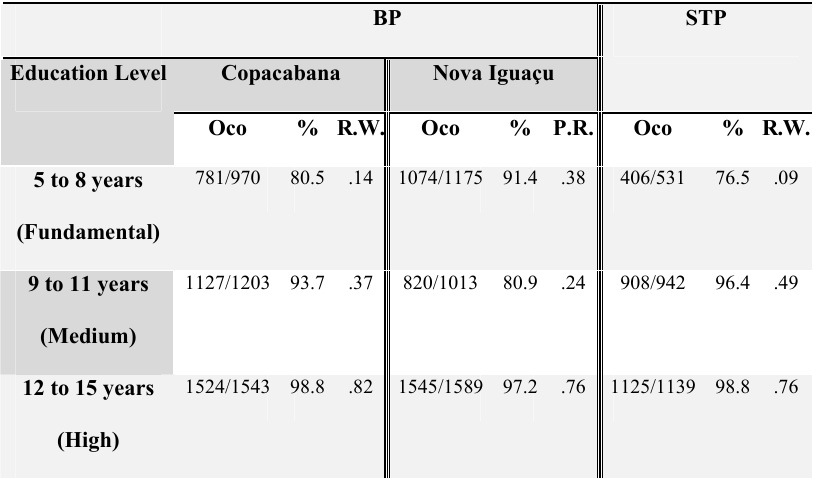
Table XI. Actuation of education level for implementing the number mark within the